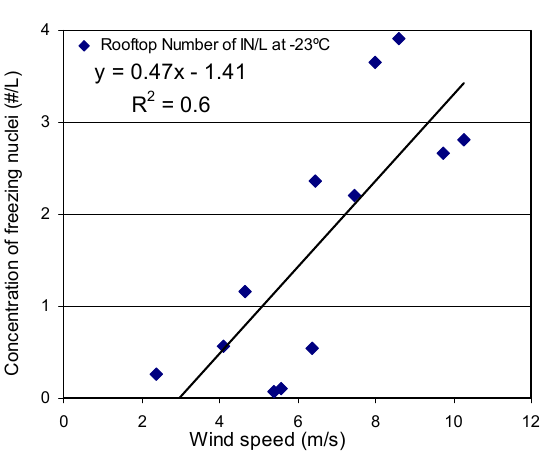
Fig. 7a: Concentration of freezing nuclei at -23ºC as a function of wind speed.